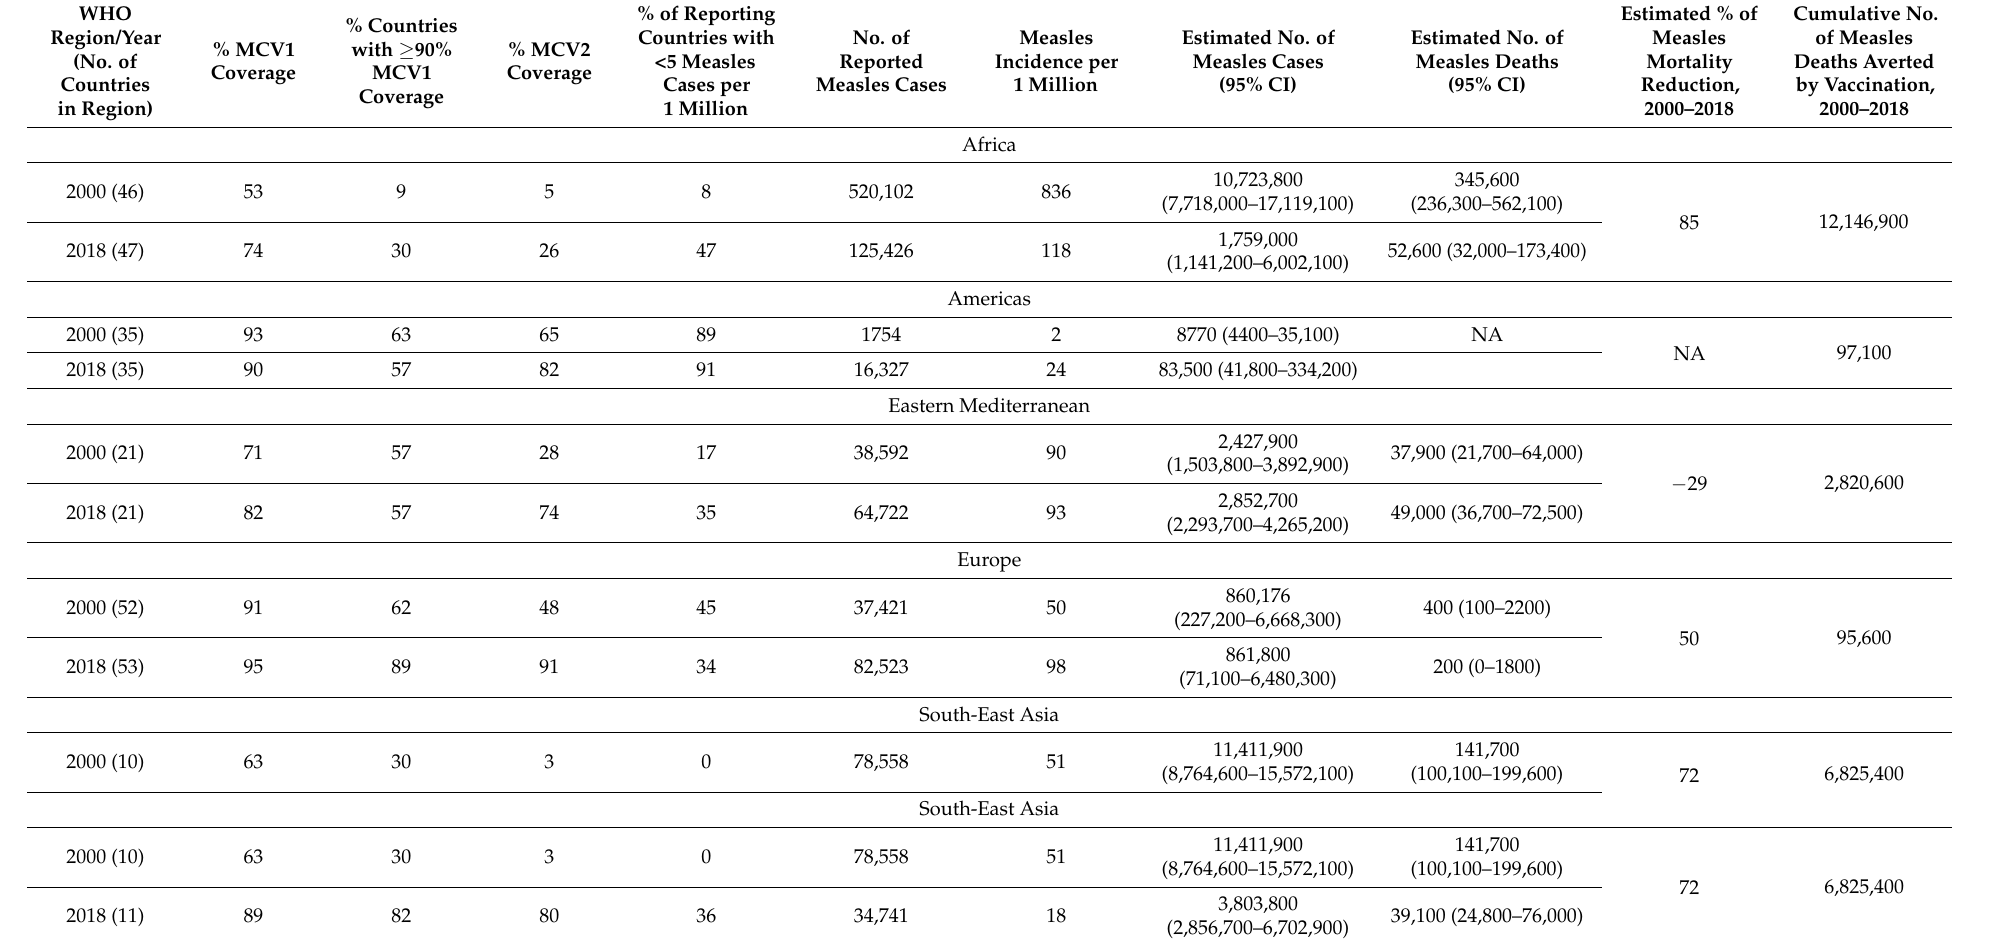
Table 1. Progress towards measles elimination worldwide from 2000 to 2018 by the